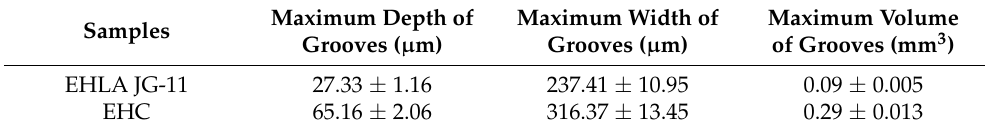
Table 5. Test results of scratch grooves.